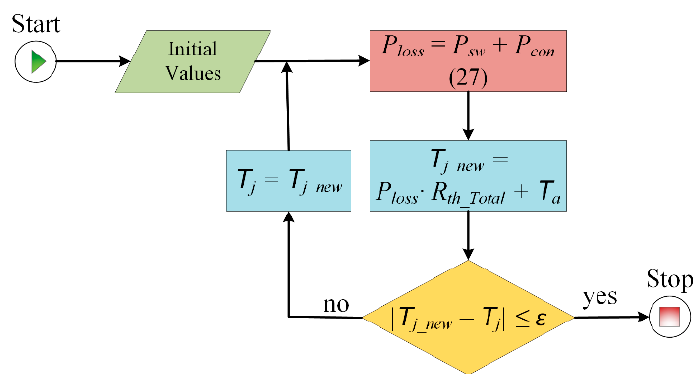
Figure 8. Junction temperature evaluation flowchart.